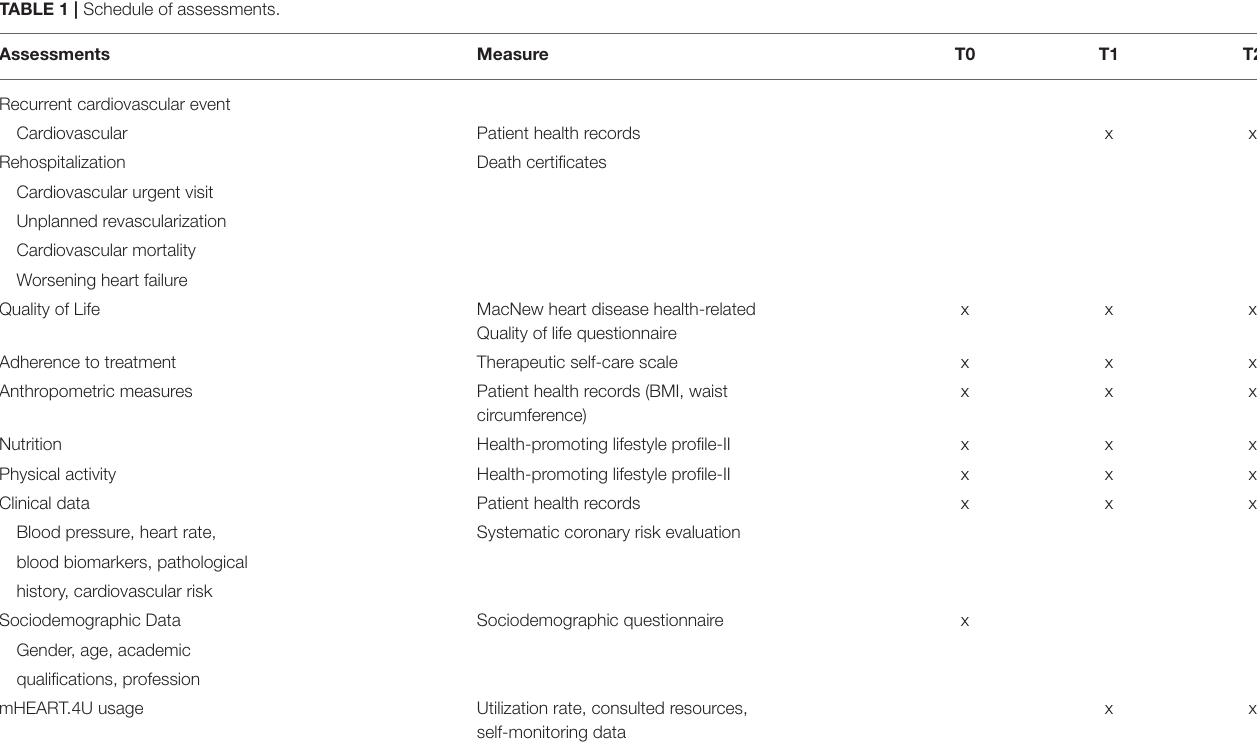
TABLE 1 | Schedule of